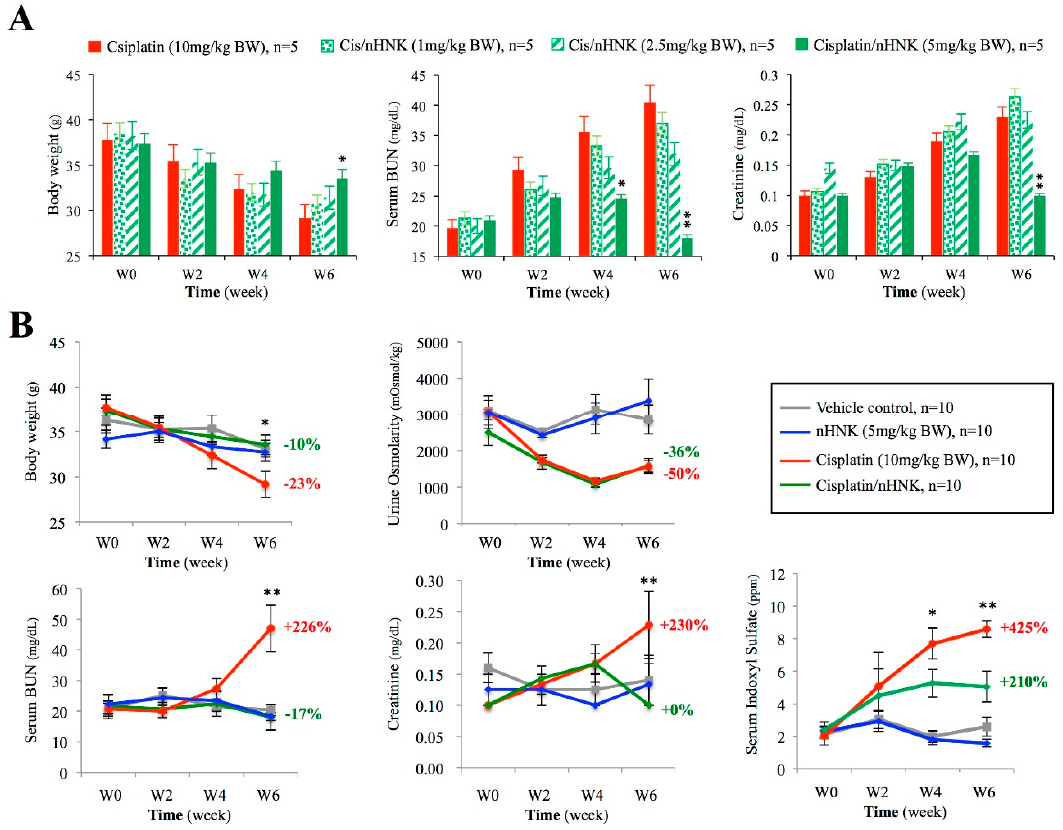
Figure 1. Influences of nanosome Honokiol (nHNK) on selected physiological parameters concerned with renal function. Cisplatin-induced kidney injury and the e ff ects of nanosome honokiol were evaluated by body weight, urine osmolarity, serum blood urea nitrogen (BUN), creatinine, and serum indoxylsulfate. ( A ) Dose-dependent evaluation showed the lowest e ff ective concentration of nHNK to restore cisplatin-induced renal damages and loss of body weight is 5 mg / kg body weight ( B ) Cisplatin administration caused reduced body weight ( − 23%) and urine osmolarity ( − 50%) with increased serum BUN ( + 226%), creatinine ( + 230%) and serum indoxulsulfate ( + 425%) in mice at the end of six weeks. Mice in the treatment group (green lines), besides urine osmolarity (–36%), exhibited improved renal functions as evaluated by serum BUN (–17%), creatinine ( + 0%), and indoxylsulfate ( + 211%). The percentage shown at each graph represents the relative changes of indicated physiological parameter at the sixth week as compared with its own value at the starting point (0 week). Experiments were carried out with six animals in each group (24 animals in total), and analyses were performed bi-weekly. Data are presented as mean ± standard deviation (SD). Asterisks indicated significant ( p < 0.05) di ff erence between the cisplatin-injured group (red lines) and the treatment group (in green). Statistics was performed with one-way analysis of variance (ANOVA) followed by a Kruskal Wallis test. Table 1. Kidney physiological parameters (value ± S.D.).